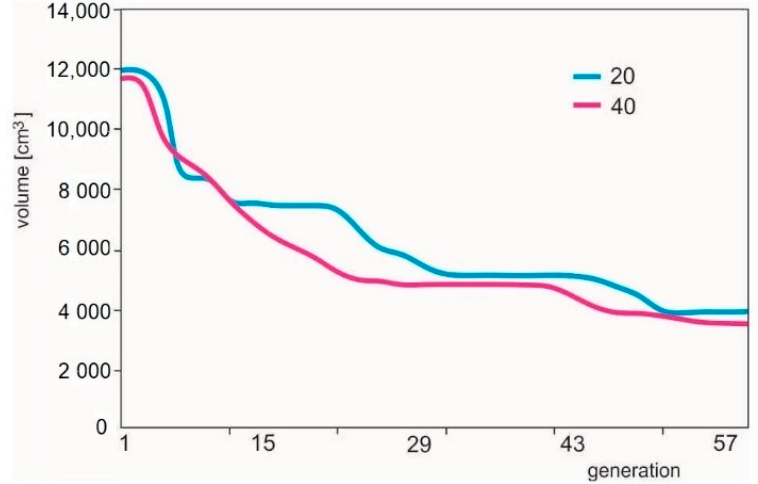
Figure 3. Changes of volume of bars during the optimization of a 25 bar structure (for 20 individuals and 40 individuals, respectively).